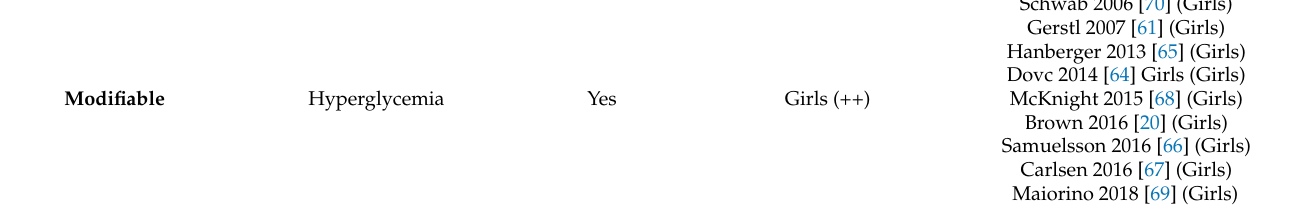
Sex with Higher Overall Study Burden (Degree) 1 (Sex Difference Girls vs.